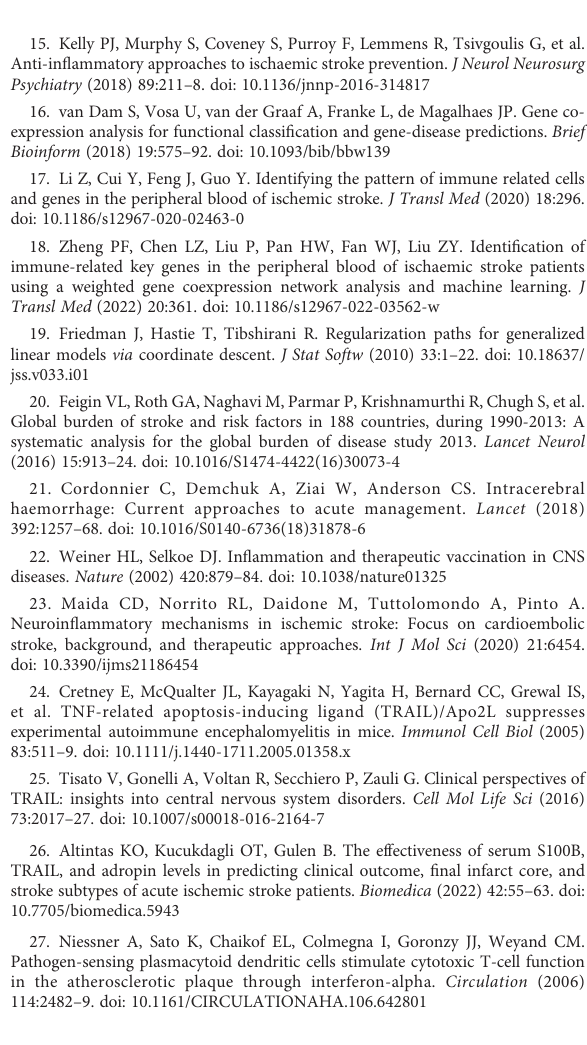
SUPPLEMENTARY FIGURE 1 Constructing the WGCNA (A) Scale independence of various soft- threshold values; (B) Mean connectivity of various soft-threshold values; (C) Clustering dendrograms of all genes with dissimilarity based on the topological overlap, together with assigned module colors; (D) The distance in 16 gene co-expression modules